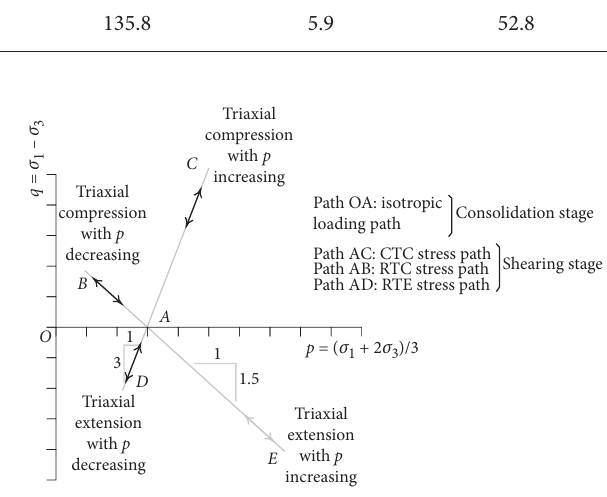
Figure 2: Three stress-path